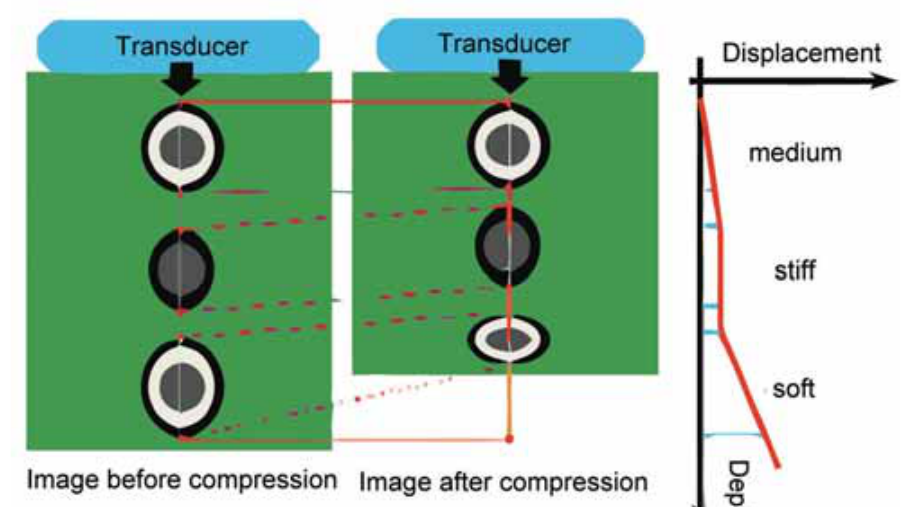
FIGURE 1. Displacement due to compression varies according to tissue stiffness. displacement in soft tissue is high, whereas stiff tissue show no or very little